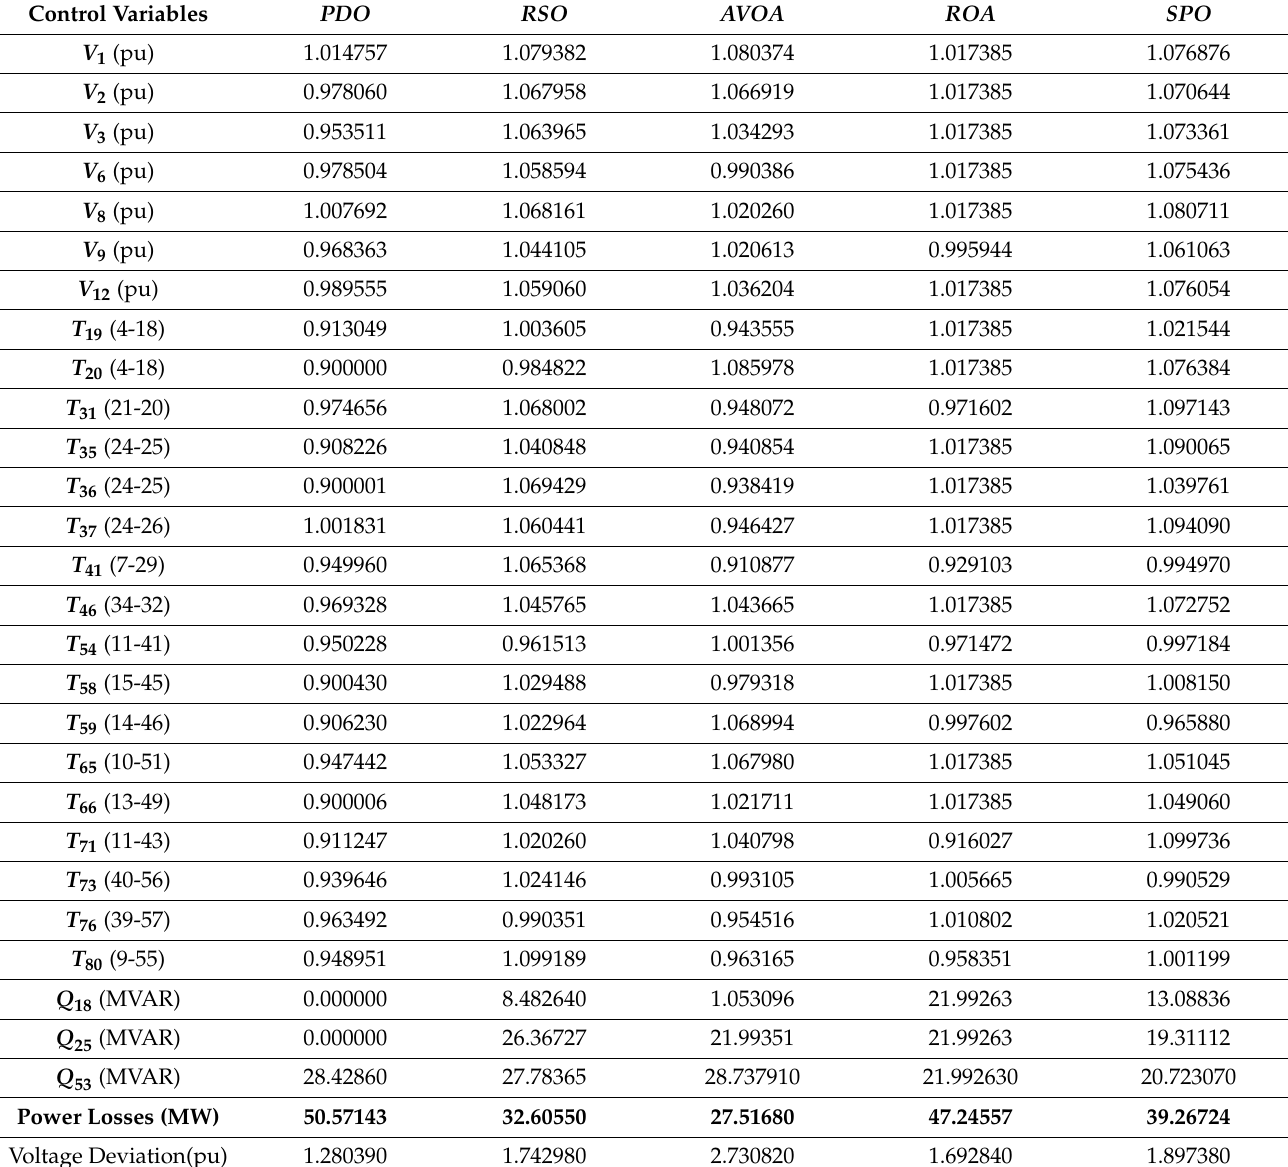
Table 20. Optimal IEEE 57-bus test system control variables for reducing power